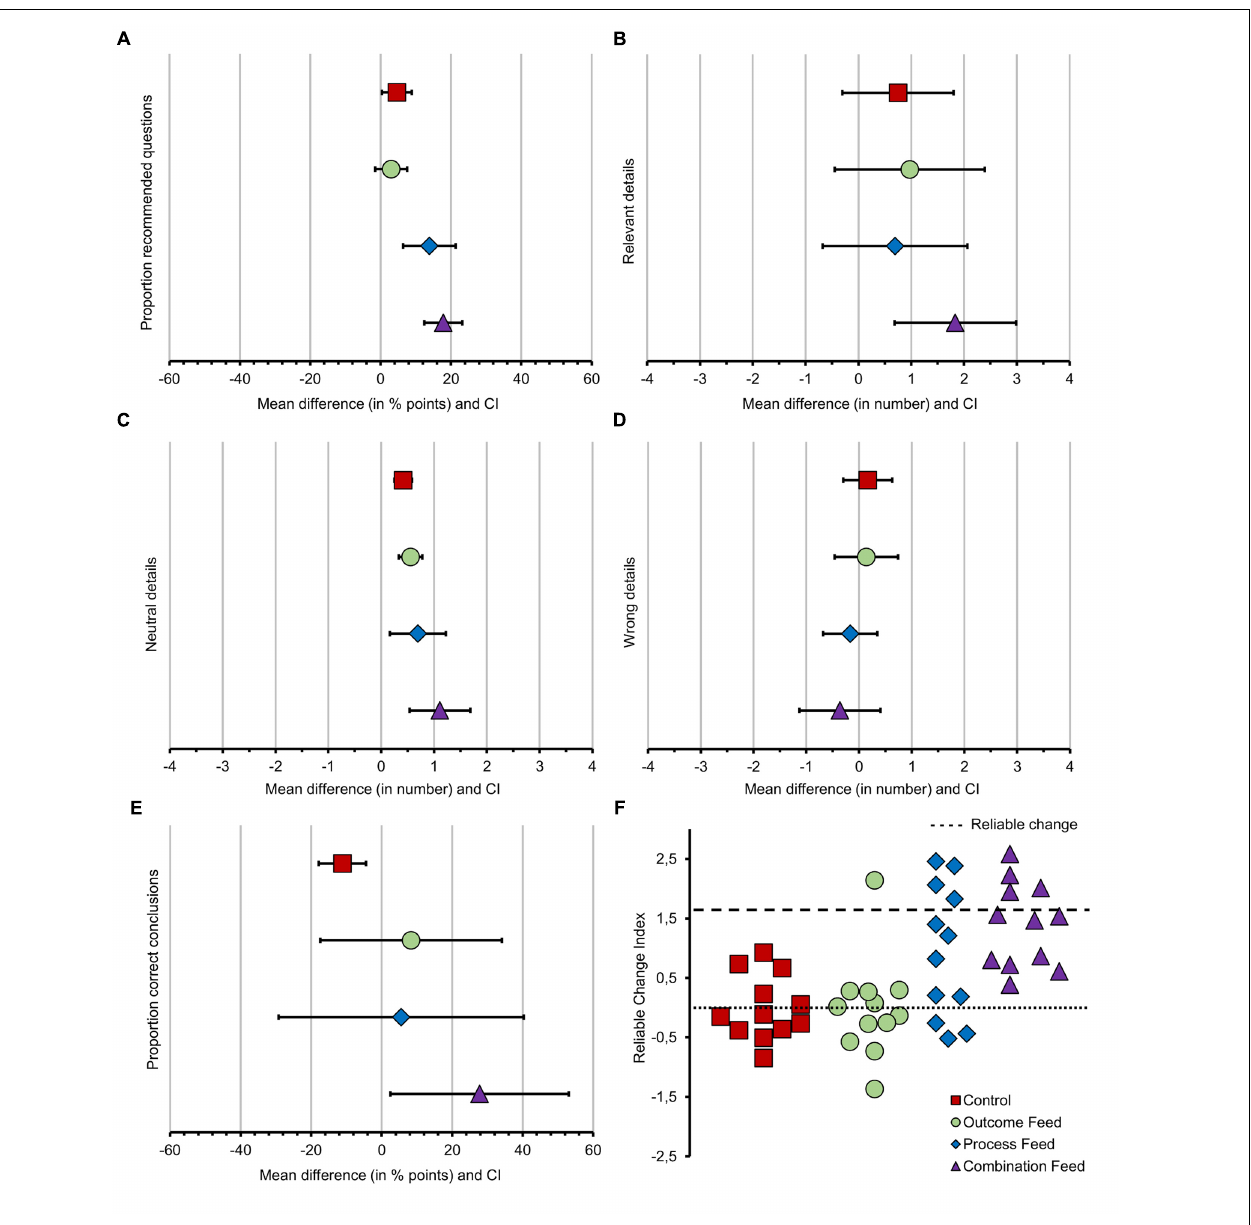
FIGURE 1 | Mean differences between the first interview and the average value of the last three interviews and reliable change by group. In panels (A–E) (from left to right), the x -axis displays the mean difference with CI between the first and the last three interviews, divided by groups. Panel (A) represents the mean gain for the proportion of recommended questions in % points. Panel (B) represents the mean gain for the number of relevant details in numbers. Panel (C) represents the mean gain for the number of neutral details in numbers. Panel (D) represents the mean gain for the number of wrong details in numbers. Panel (E) represents the mean gain for the proportion of correct conclusions in % points. Positive numbers reveal a gain while negative numbers reveal a decrease. The only expected decrease was for the number of wrong details. Panel (F) displays the reliable change by participant per group.